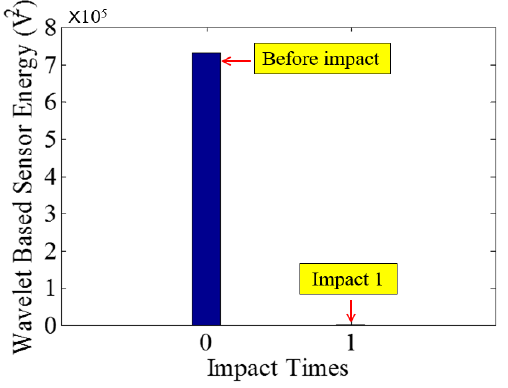
Figure 27 . Wavelet packet-based energy plots of the received signal in Mortar-2.